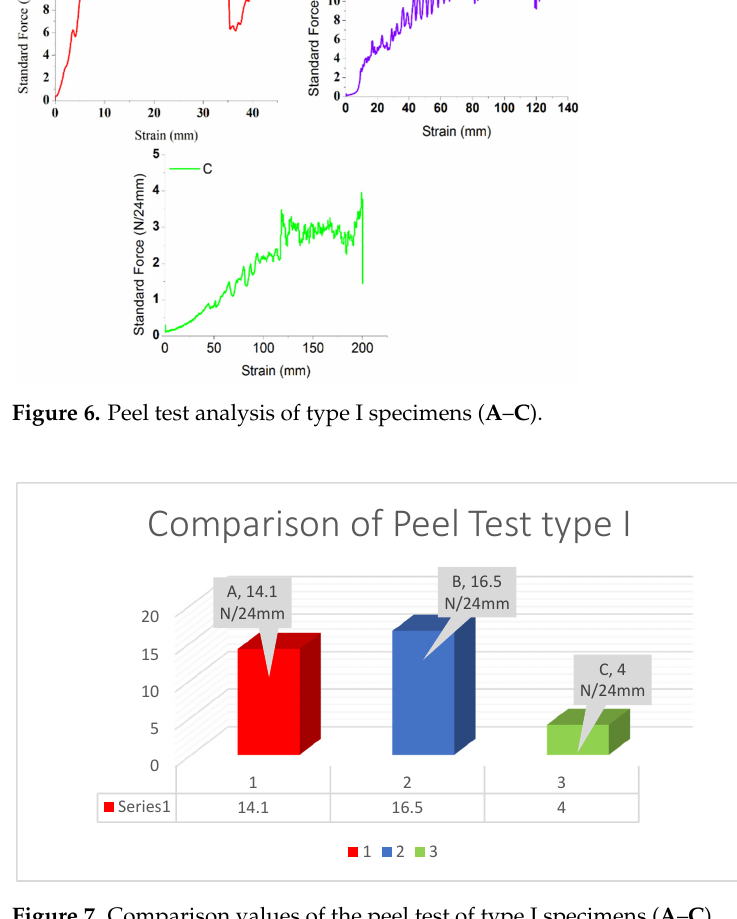
Figure 9. Difference between the peel test results of type II specimens A, B, and C. 6.3. Hardness Test A portable hardness tester was used to perform the hardness test according to the ASTM A 1038-17 standard [38]. Three samples with size 24 mm × 24 mm were prepared with different epoxy resin and epoxy hardener ratios (A = 3:2, B = 4:1, and C = 2:3). A load was applied, and the readings on the dial were noted down. Shore A Hardness Test (Table 3): 01020 3040